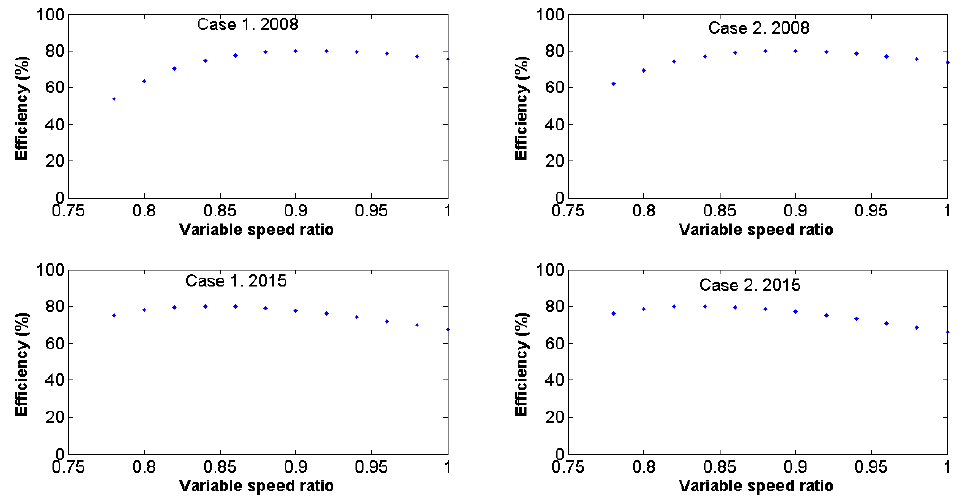
Figure 8. Pump efficiency (%) depending on the variable speed ratio in WUA A.